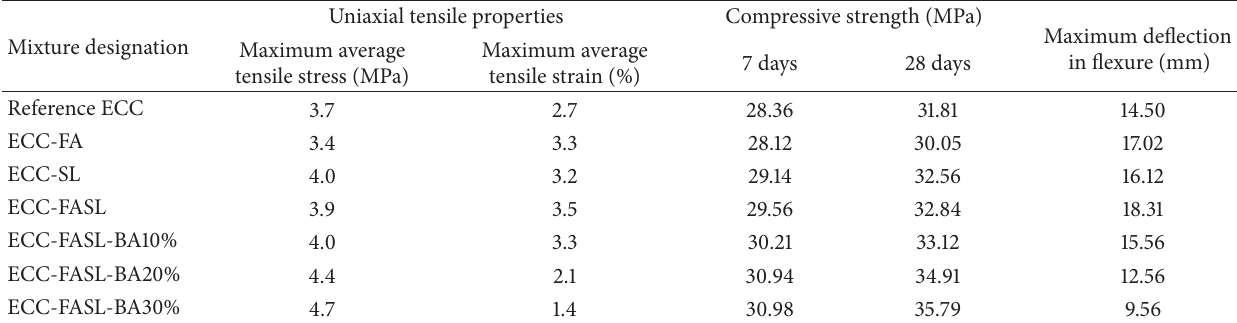
Table 6: Mechanical properties of all ECC